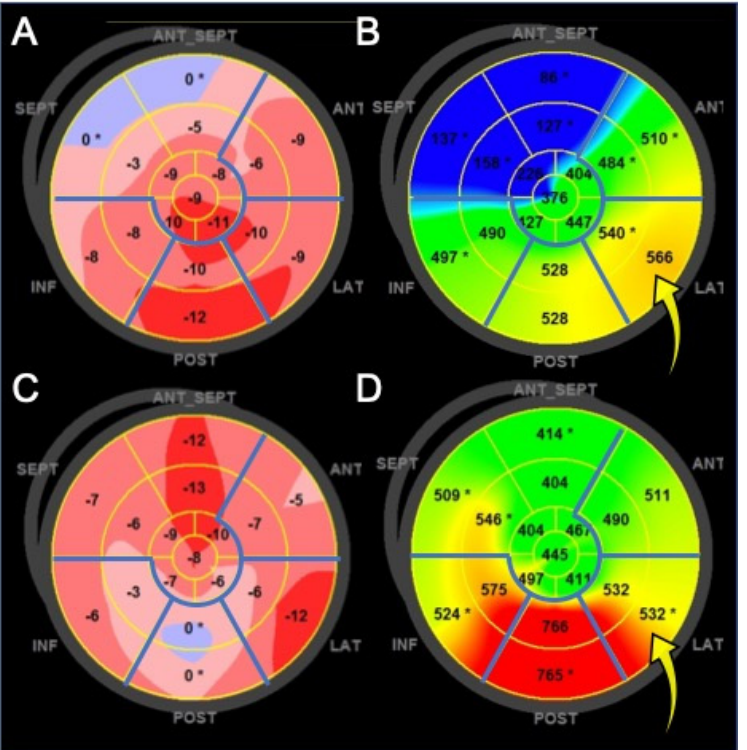
Figure 4. Left ventricle (LV) color-coded polar maps of longitudinal myocardial strain. Panels on the left: map of strain amplitude. Clear pink and blue colors identify the most dysfunctional areas. Panels on the right: map of time-to-peak strain (dyssynchrony map). The red color represents the latest contracting myocardial areas. Basal and mid myocardial segments of inferior, posterior, lateral, and anterior walls (demarcated by the blue lines) are potential sites for LV pacing. ( A , B ) Patient with viable myocardium at the basal lateral wall, which is the site with latest contraction delay (optimal pacing site, yellow arrow). ( C , D ) The posterior wall is the most dyssynchronous, as indicated by the red color on the dyssynchrony map, but it is not the optimal pacing site because of the very low contraction amplitude. The best site for LV pacing is the lateral wall, although it is not the most delayed (yellow arrow).